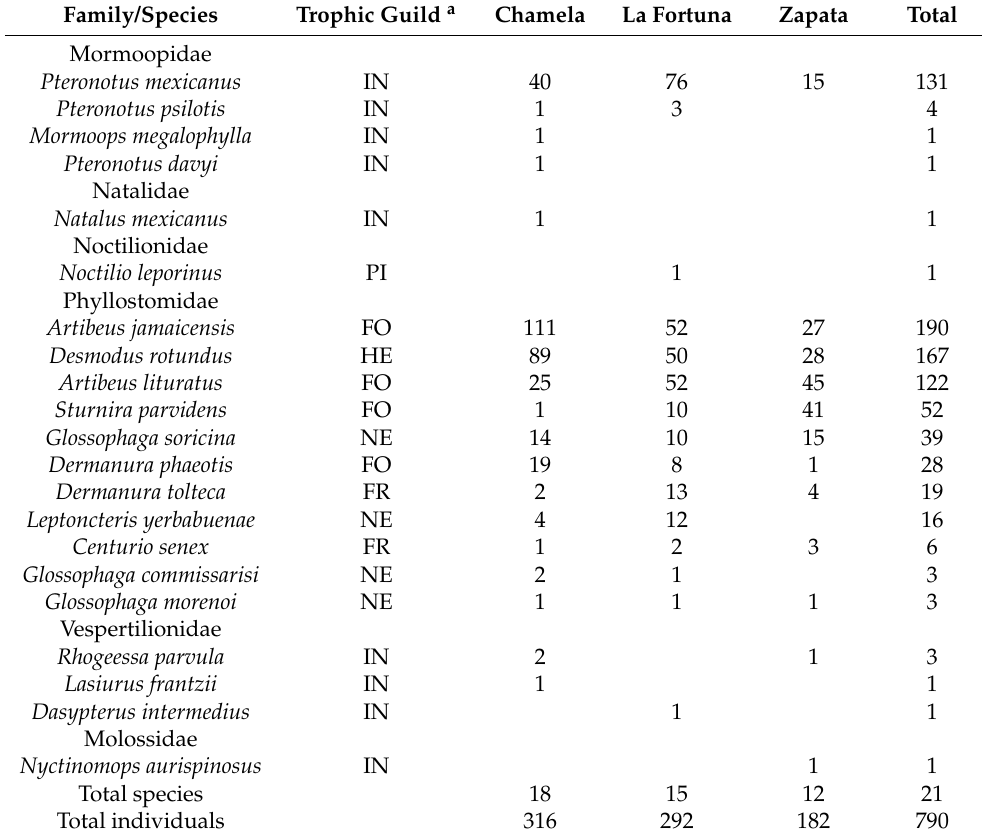
Table 1. Number of individuals captured at each study